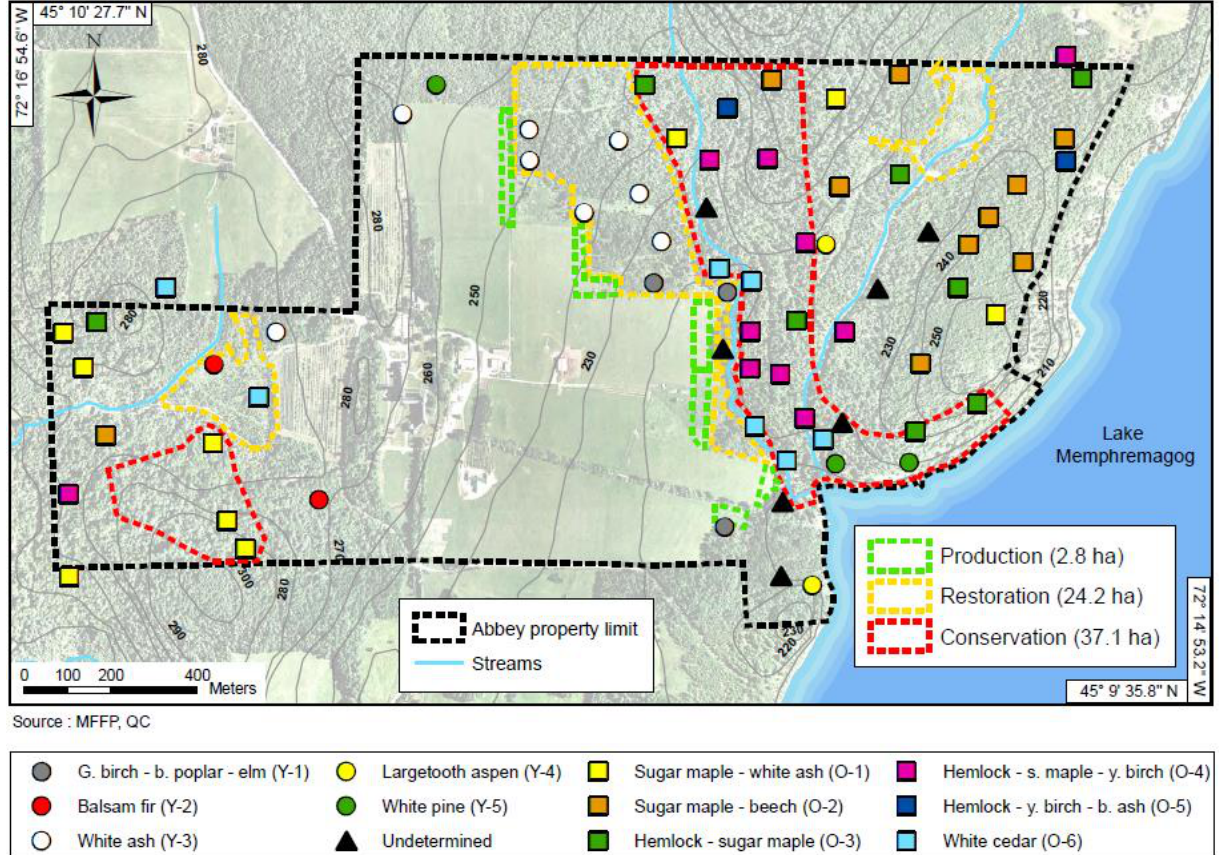
Figure 4. Projected Base case zoning scenario for the St-Benoît-du-Lac Abbey